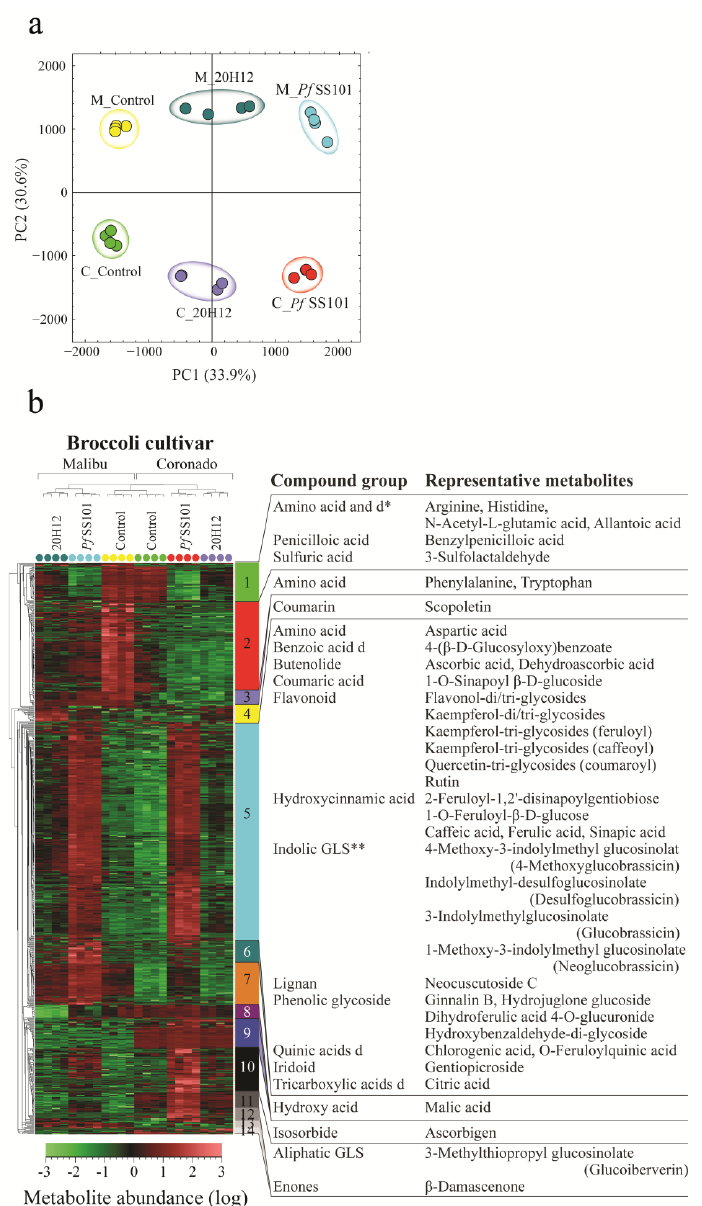
Figure 4. Metabolome changes in the shoots of two Broccoli cultivars, Coronado and Malibu upon root treatment by P. fluorescens SS101 or its cysH mutant 20H12. Shown are the results of the PCA ( a ) and HCA ( b ) based on differentially regulated semi-polar metabolites. In the HCA, various metabolite clusters are indicated by different colors; when none of the metabolites in a given cluster was annotated, the cluster number was omitted (clusters 3, 6, 8, 9, 12, 13, and 14 in panel b). * GLS, glucosinolate; ** d, derivative.